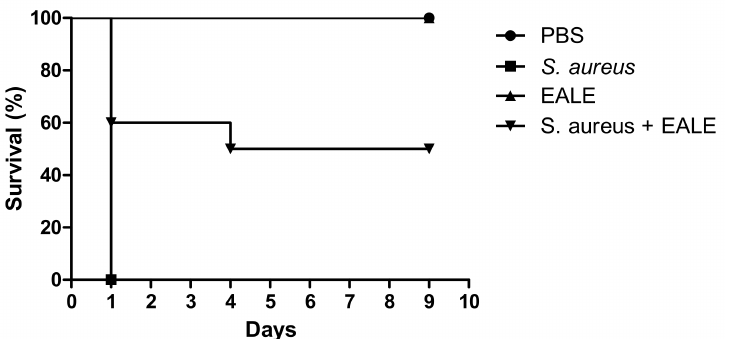
Figure 2. Effect of the Humiria balsamifera (Aubl) EALE treatment on the lifespan of Tenebrio molitor larvae during infection by S. aureus ATCC 6538. The larvae were treated with EALE at a dose of 3.12 mg/kg. Negative control groups injected with PBS (phosphate-buffered saline) were also included.